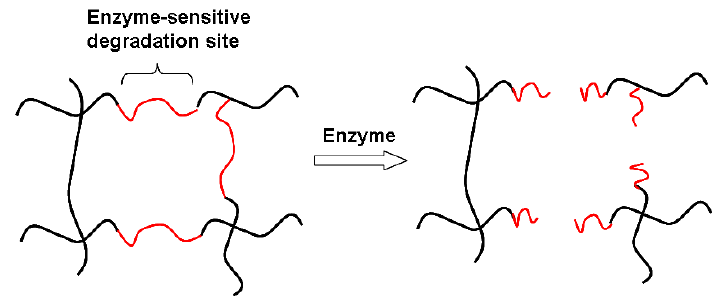
Figure 5. In vivo degradation of a polymer network ( e.g. , cellulose hydrogel) functionalized with enzyme-sensitive moieties ( e.g. , hyaluronic acid). The degradation rate is dependent on the amount of degradable sites as well as the degree of crosslinking of the network, which affects enzyme diffusivity through the mesh